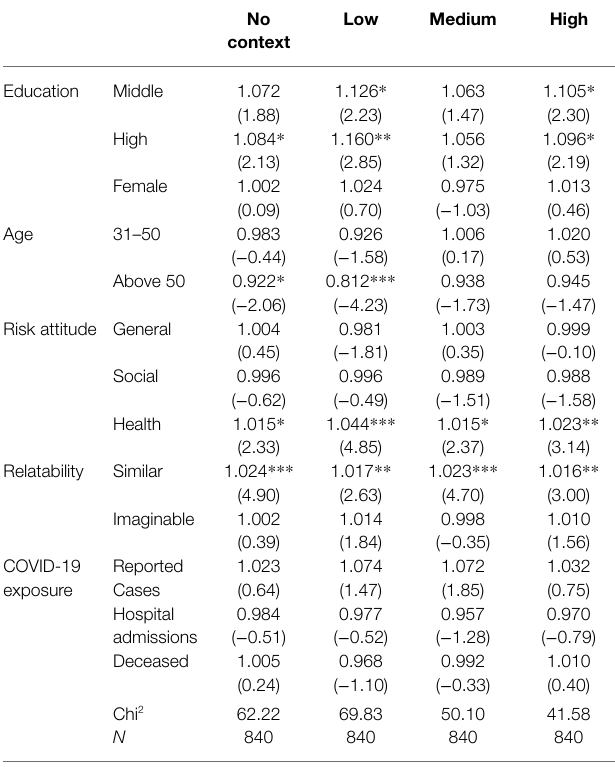
TABLE 7 | Fully integrated logit regression: personal and location-dependent characteristics and decision to go. Integrated model: marginal effects resulting from logit